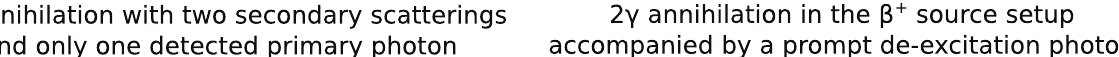
Fig. 3 Schematic presentation of signal (o-Ps → 3 γ ) and background events in the transverse view of the J-PET detector. The grey rectangles represent photon detection modules of plastic scintillators (only one layer is shown for readability). The modules in which photons were recorded are marked white. The annihilations take place in the wall of the vacuum chamber (grey band). In a signal event a , all three photons from an ortho-positronium annihilation are recorded and the angles between their momenta, labelled according to ascending magnitude ( θ 1 < θ 2 < θ 3 ), obey θ 1 + θ 2 > 180 ∘ . The background is dominated by direct e + e − → 2 γ annihilations, where the third recorded photon comes from secondary Compton scattering in the detector b , resulting in the identi fi cation of a spurious primary photon marked with a dashed arrow. Three-photon events may also be caused by two subsequent secondary scatterings in the case where one of the direct annihilation photons is not detected c , and by two-photon annihilations originating in the β + source setup (grey circle) accompanied by a prompt 22 Ne * de-excitation photon depositing low energy in Compton scattering d